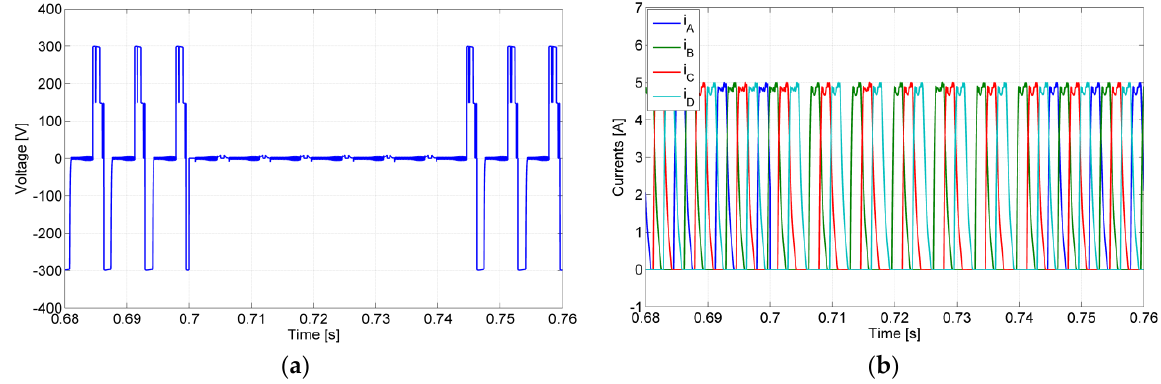
Figure 11. Simulation test with the converter operating in normal mode until t = 0.695 s and after that with an open-switch fault in the semiconductor S 21 ( a ) winding voltage of phase A ; ( b ) winding currents. Fault-tolerant mode after t = 0.742 s.